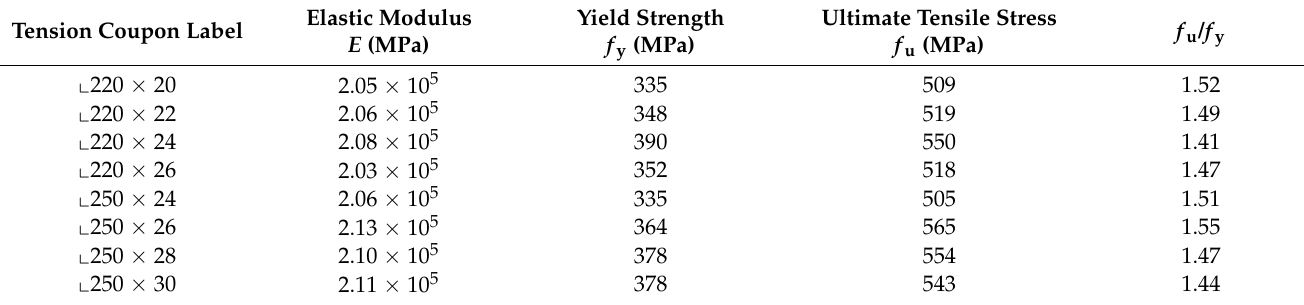
4 of 27 Table 1. Tension coupon test results. Tension Coupon